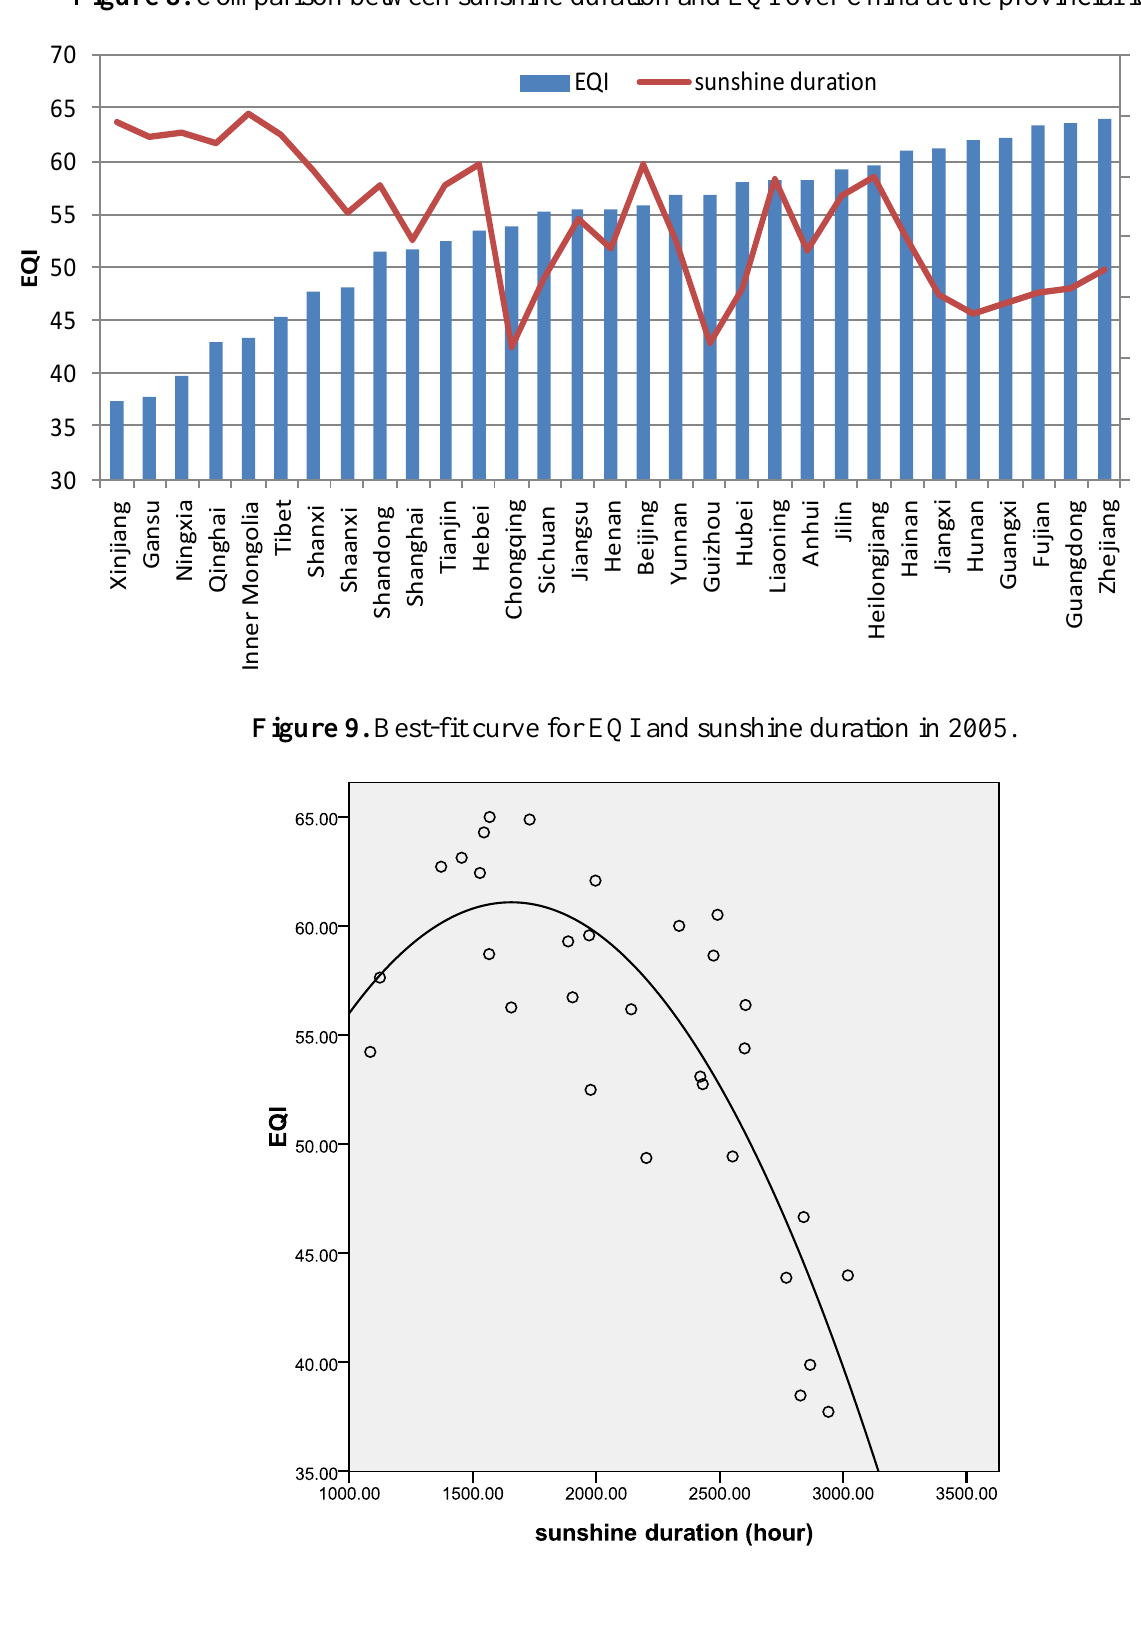
Figure 8. Comparison between sunshine duration and EQI over China at the provincial level.